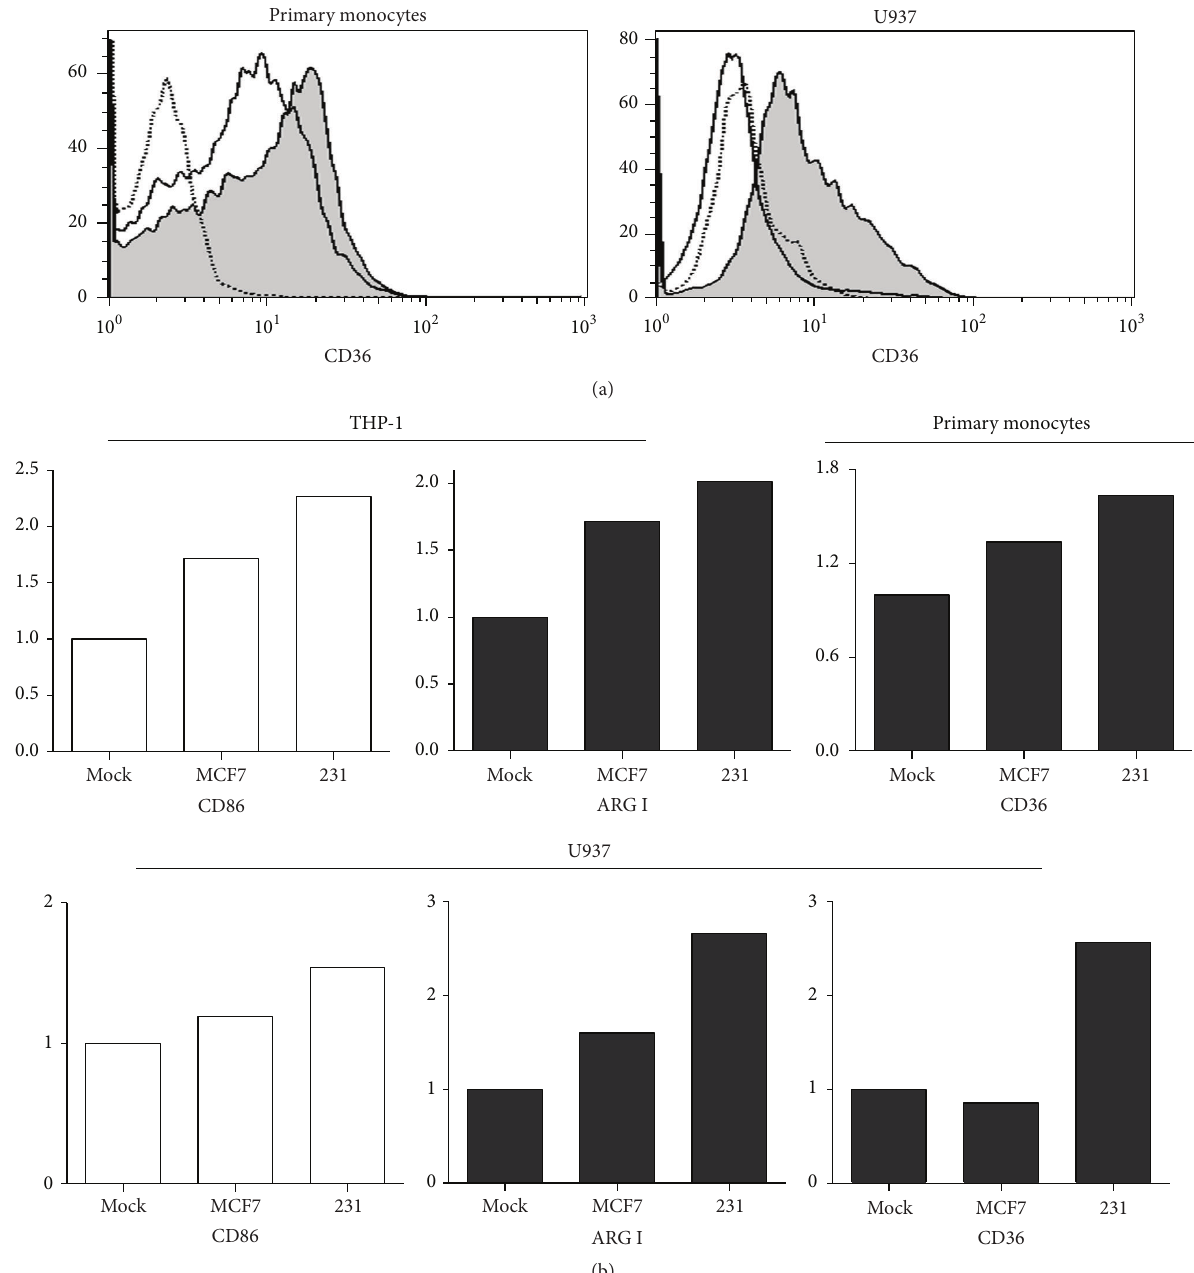
Figure 6: M1 and M2 polarization induced by breast cancer cell lines. After treatment of all three types of monocytes with either MCF-7 or MDA-MB-231 conditioned media, cells were harvested and the panel of M1/M2-related markers was analyzed by flow cytometry. In (a) the result for M2-related marker CD36 in primary monocytes and U937 cells is depicted: dotted line histograms represent autofluorescence control and straight line and shaded histograms correspond to stimulation with MCF-7 and MDA-MB-231 conditioned media, respectively. In (b) the autofluorescence was used to normalize marker expression, a value of 1 to the level of autofluorescence, and expression after treatment with conditioned media was normalized dividing by this basal value. Fold changes are depicted and the markers represented are only those with changes ≥ 1.5-fold. White bars represent M1 markers and black bars M2